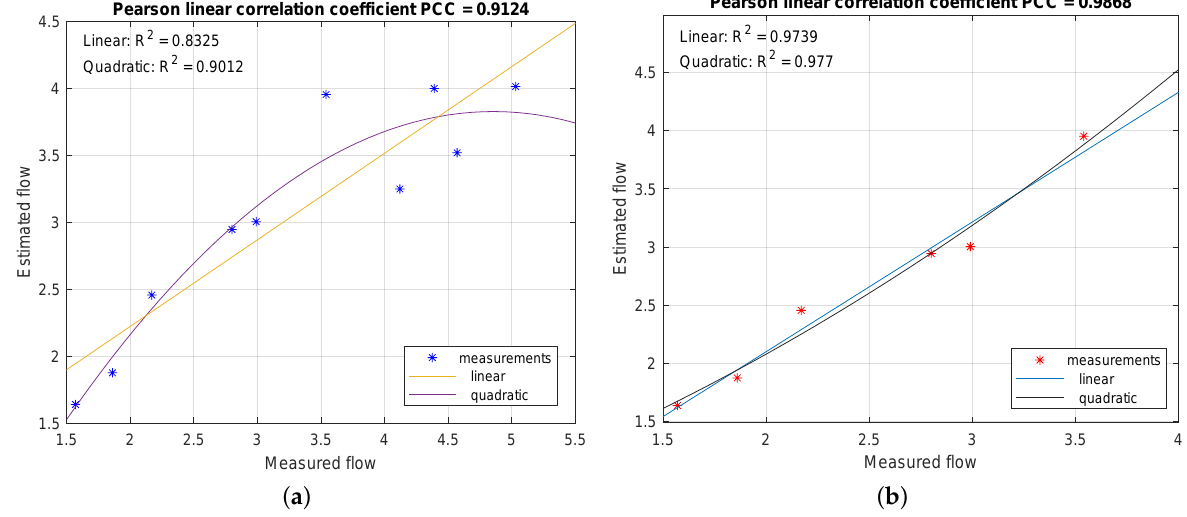
Figure 6. The relationships between the uncalibrated estimates achieved using the proposed method and the velocities measured using the water-flow meter: ( a ) for the whole range 1.5–5.0 dm 3 /s; ( b ) for the typical range 1.5–3.7 dm 3